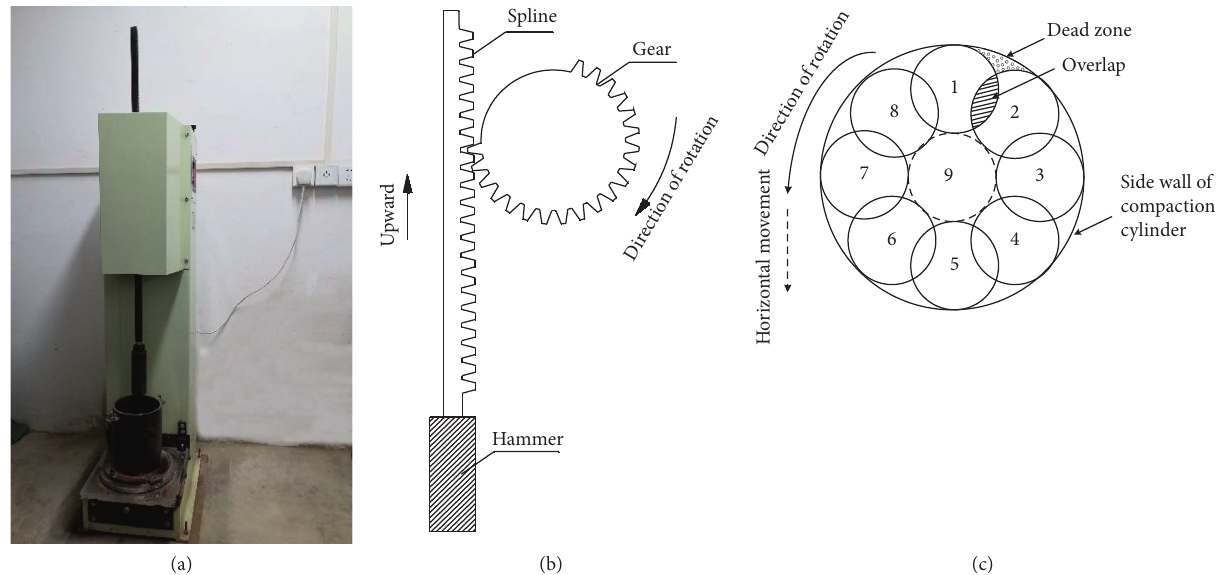
Figure 2: Compaction apparatus adopted in this study: (a) pictures of apparatus; (b) lifting mechanism of drop hammer; (c) drop locations.